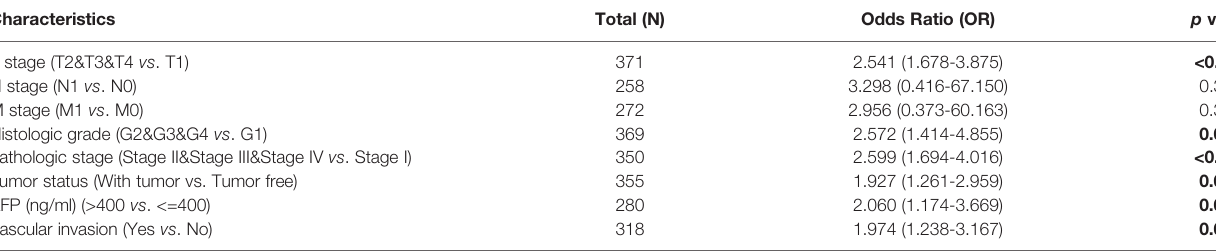
TABLE 2 | EEF1E1 expression correlated with clinical pathological characteristics (logistic regression).